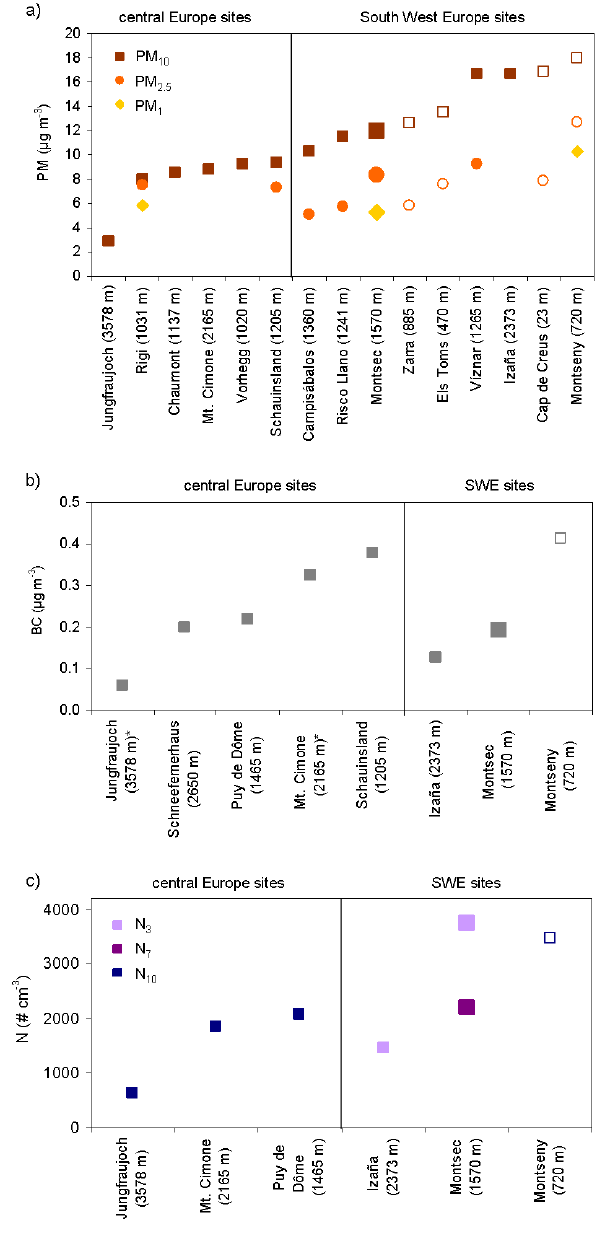
Fig. 3. Three-year (2010-2012) arithmetic average concentrations of (a) PM, (b) BC and (c) N compared with the data available in the ACTRIS Data Center web site. ∗ Jungfraujoch and Mt. Cimone BC concentrations averaged from 2007 to 2009. Non-solid markers correspond to non-high-altitude